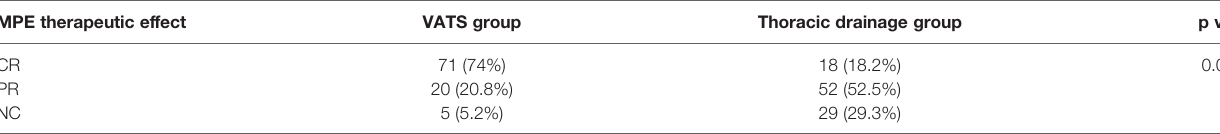
TABLE 4 | Comparison of the MPE therapeutic effect between the two groups.